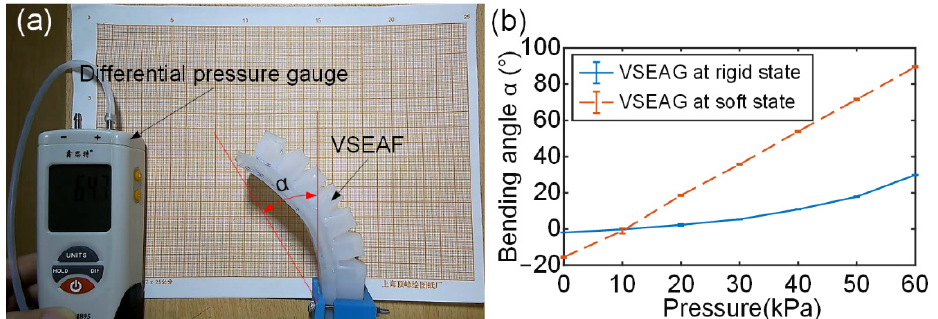
Figure 8. Bending performance test of the VSEAF: ( a ) test rig, ( b ) test results.